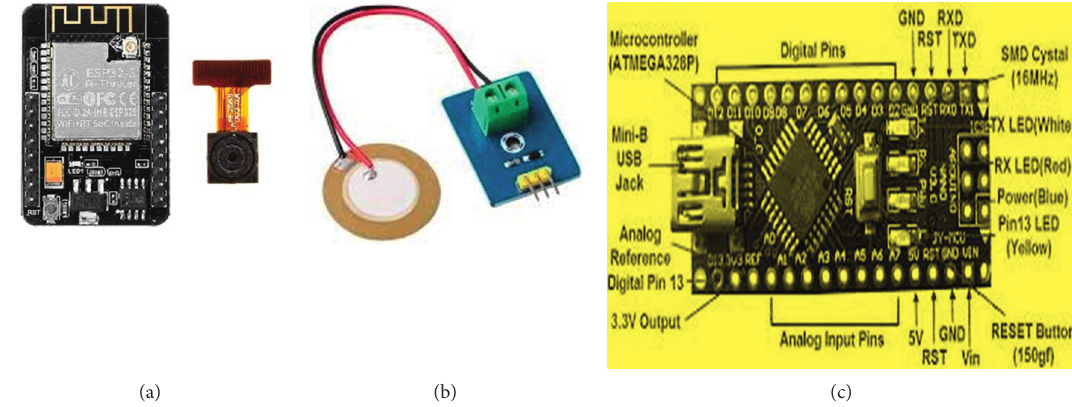
Figure 1: Some components of the UAV: (a) ESP32-CAM camera, (b) piezoelectric sensor, and (c) Arduino nanocontroller.